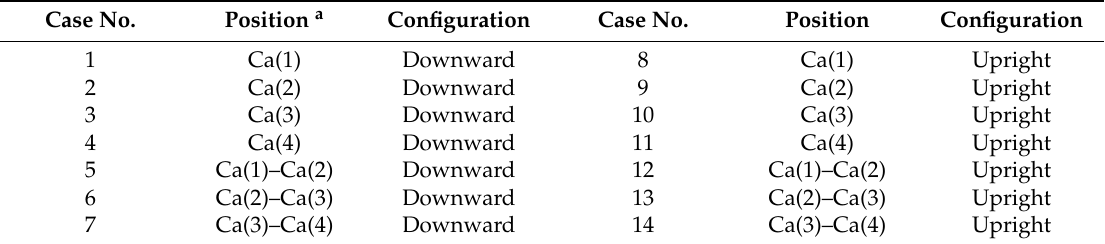
Table 2. Starting geometries for a water molecule on the M3-C 3 S (111)